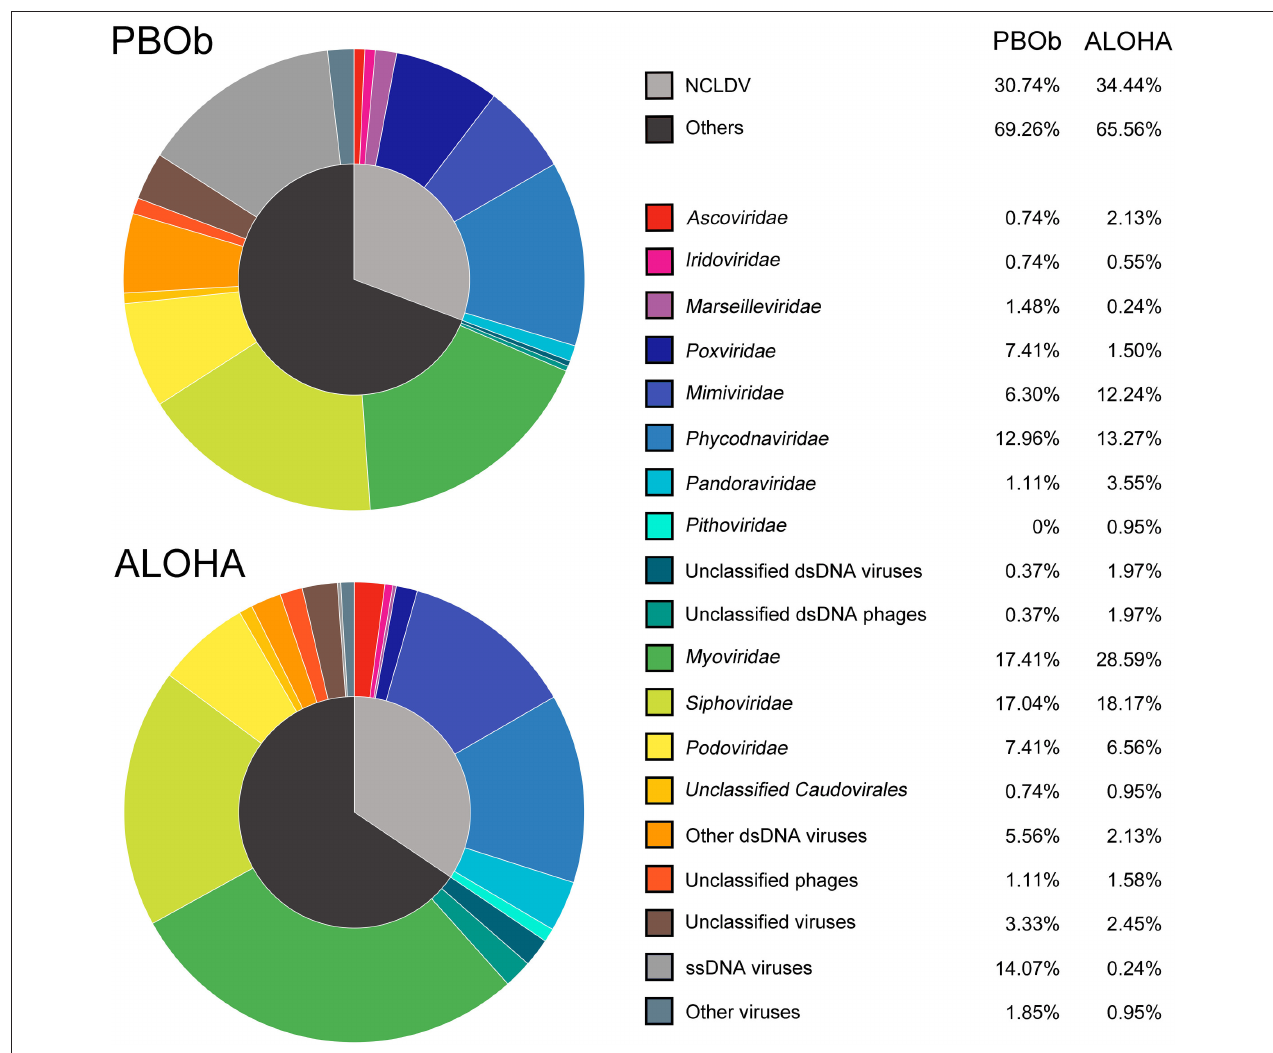
FIGURE 8 | Comparison of viral taxonomic compositions between PBOb and deep sea sample of ALOHA station. The non-normalized taxonomic composition data based on contigs best BLAST hit (threshold of 50 on the BLAST bit score) of PBOb (Project ID 8183) and ALOHA station deep abyss (Project ID 3816) were downloaded from MetaVir2 server. Different colors refer to different viral groups showed in the legend on the right